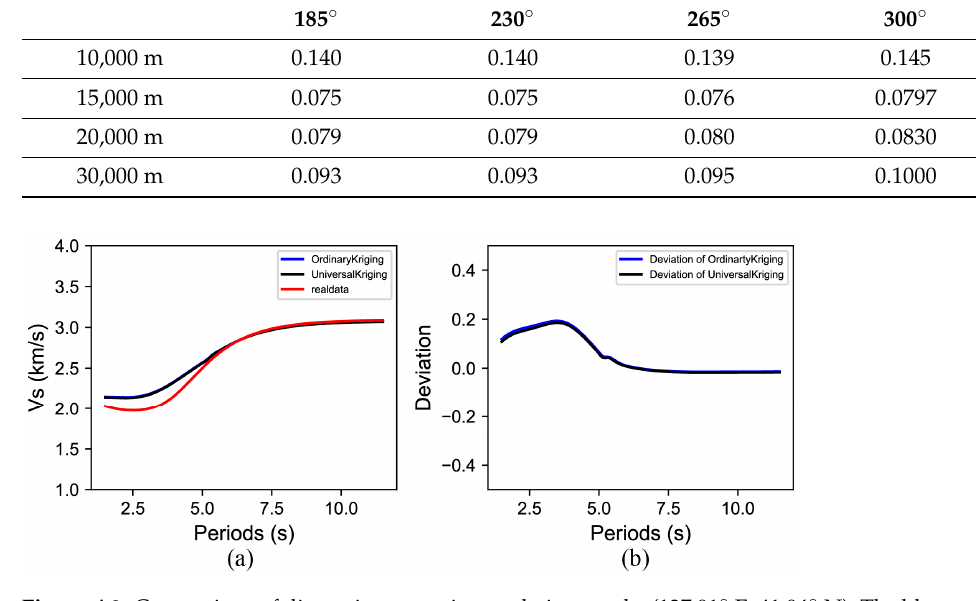
Figure A5. Comparison of dispersion curve interpolation results (128.18° E, 41.76° N ). The blue curve indicates the ordinary kriging results, while the black curve indicates those of universal kriging: ( a ) Comparison of the dispersion curves; and ( b ) deviation of the OK (blue) or UK (black) results. Figure A6. Comparison of dispersion curve interpolation results (128.18° E, 41.82° N ). The blue curve indicates the ordinary kriging results, while the black curve indicates those of universal kriging: ( a ) Comparison of the dispersion curves; and ( b ) deviation of the OK (blue) or UK (black) results.